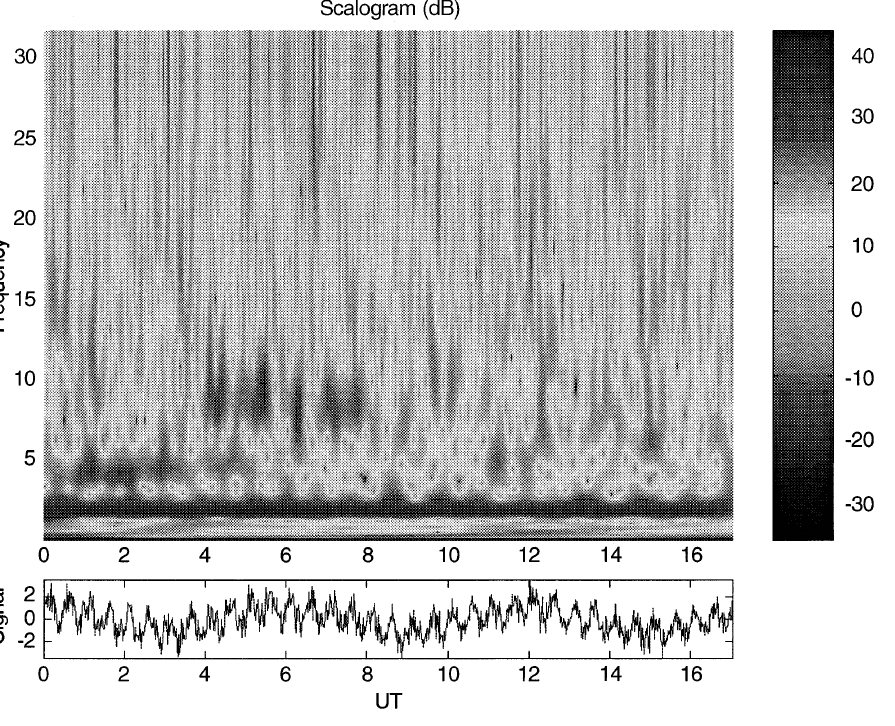
Fig. 6. Scalogram of the synthetic signal in the noisy case; frequencies are in h